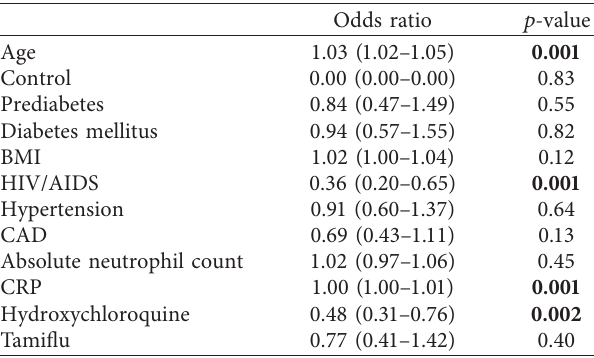
Table 5: Comparison of mechanical ventilation use based on